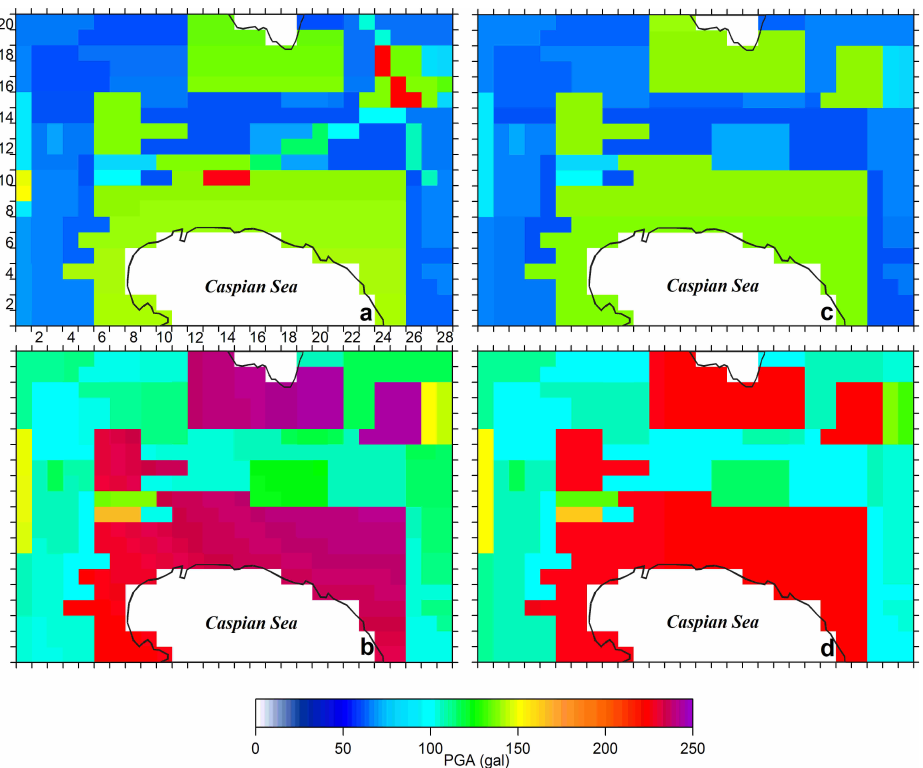
Fig. 4. Computed surface peak ground acceleration for four model scenarios: ( a ) near event (marked by 1 in Fig. 1); ( b ) local event (marked by 2); ( c ) far event (marked by 3), and ( d ) extreme event (marked by 4). Coastlines are marked by black curves here and in Figs. 5 and